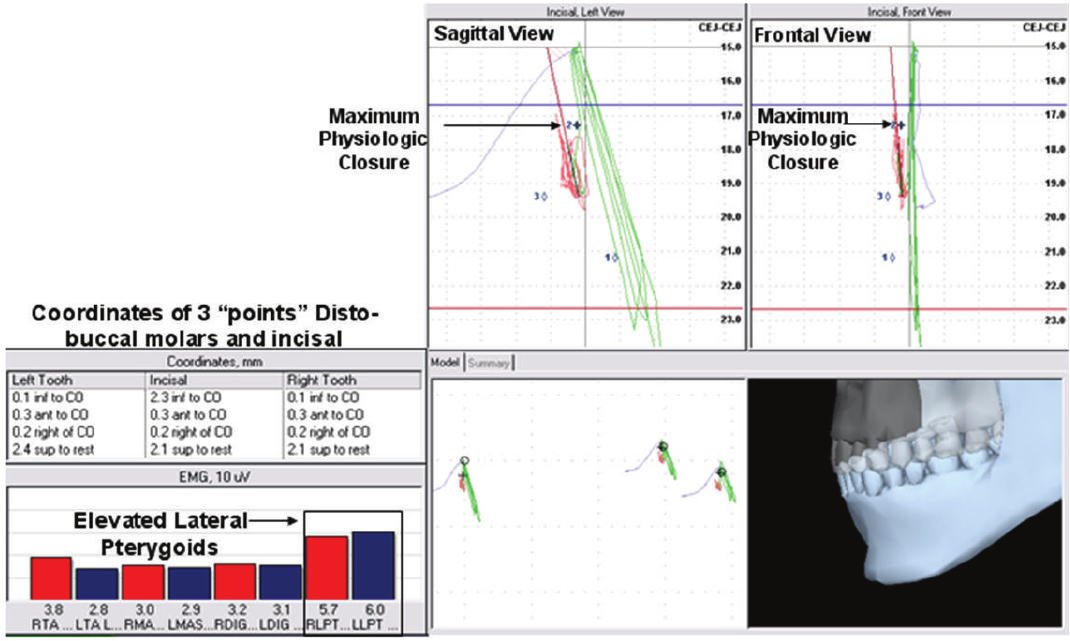
Figure 8: Spatial position of the lower jaw combined with bilateral activity of the temporalis anterior (TA), masseter (MAS), suprahyoid (DIG), and lateral pterygoid (LPT) sites. Coordinates listed are representative of mandibular position relative to centric occlusion and physiologic rest and were documented during the “burst” of LPT activity and determined to be “Maximum Physiologic